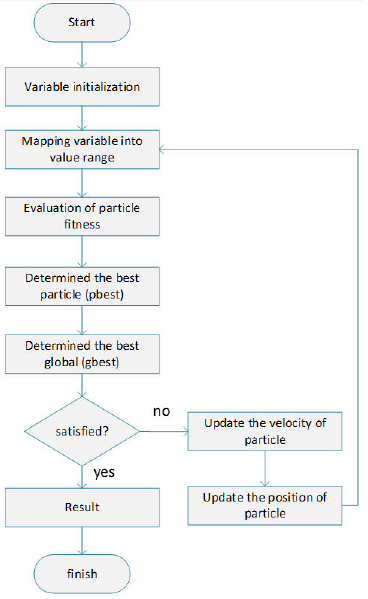
Figure 1. The flowchart of the PSO